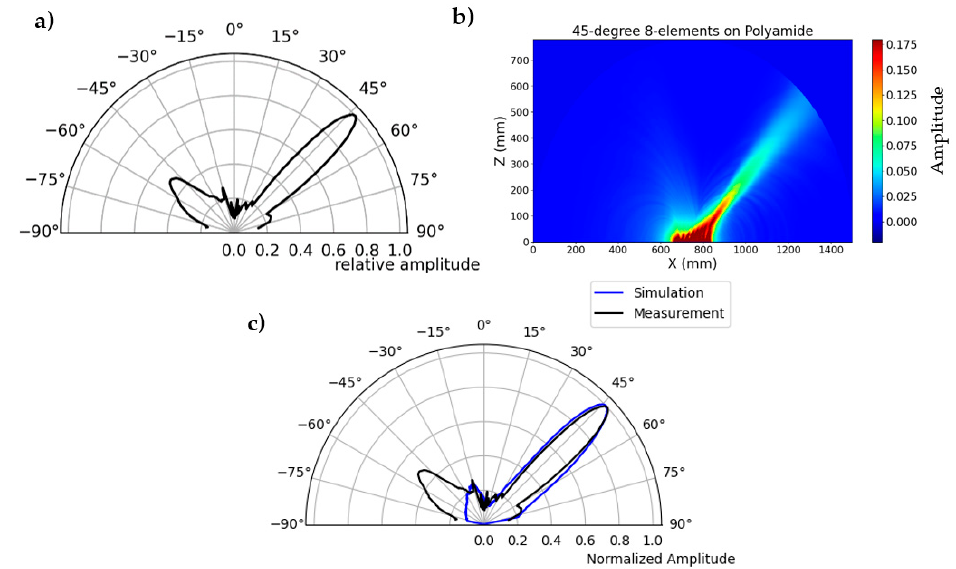
Figure 17. ( a ) Directivity measurement of second generation borehole probe, focused beam at 45°, ( b ) simulation of borehole probe based on measurement parameters, and ( c ) comparison of simulation and measurement.